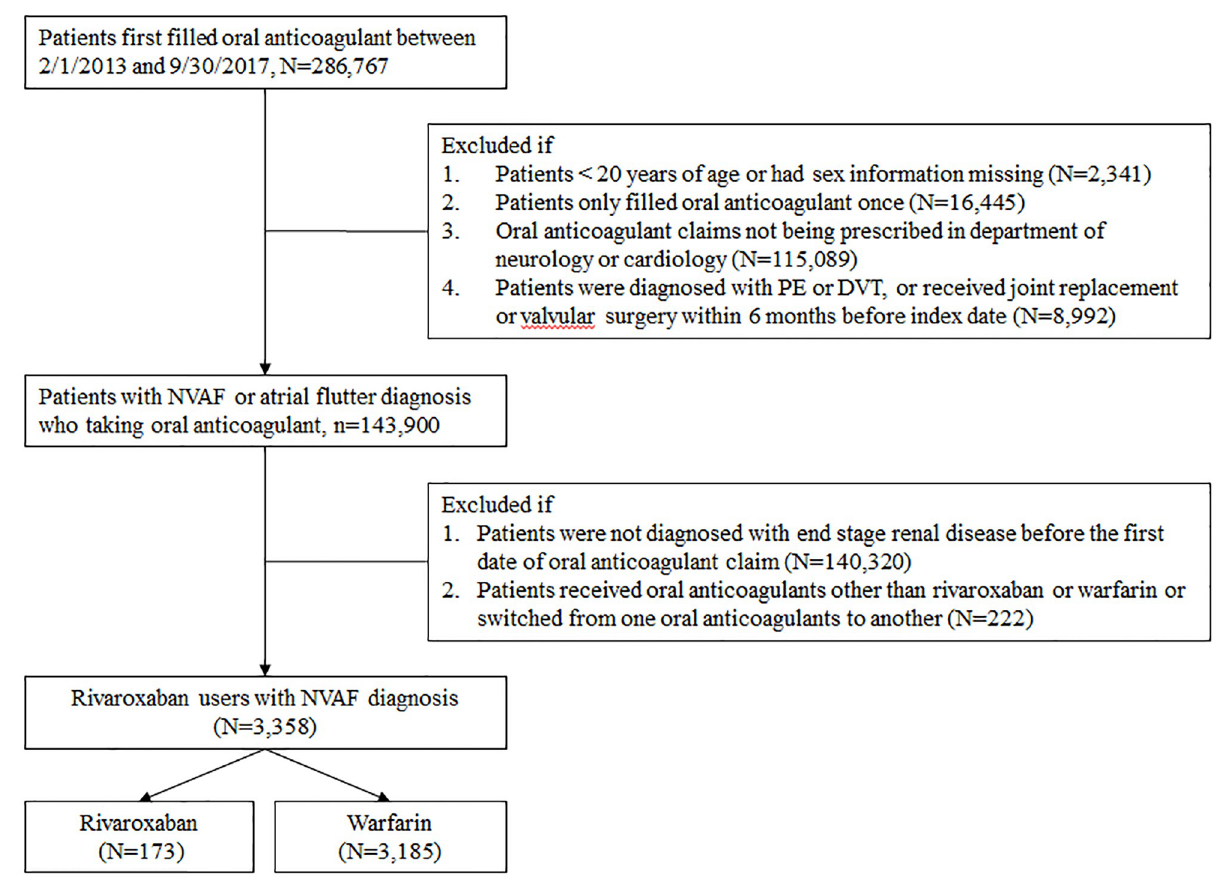
Fig 1. Patient selection process. A total of 3358 patients with NVAF and ESRD receiving either rivaroxaban or warfarin were enrolled in this study, consisting of 173 and 3185 rivaroxaban and warfarin users, respectively. NVAF = nonvalvular atrial fibrillation; DVT = deep vein thrombosis; PE = pulmonary